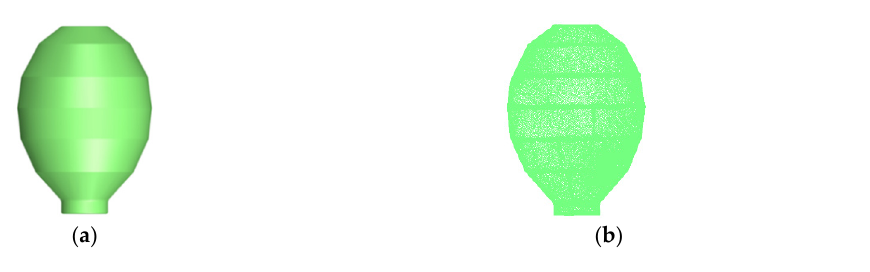
Figure 13. Photo of egg-shaped pressure hulls.